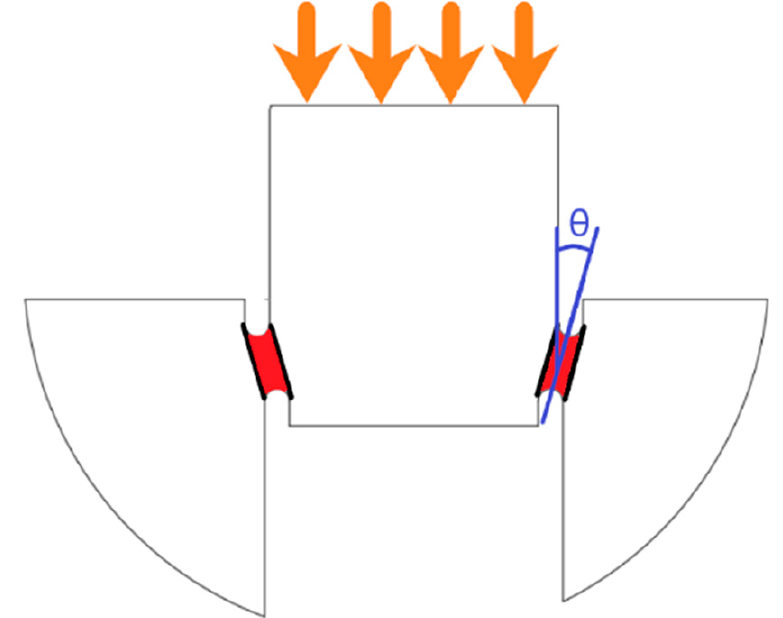
Figure 2. Schematic of specimen showing the shear notch zones (red) with a shear angle ( θ ).